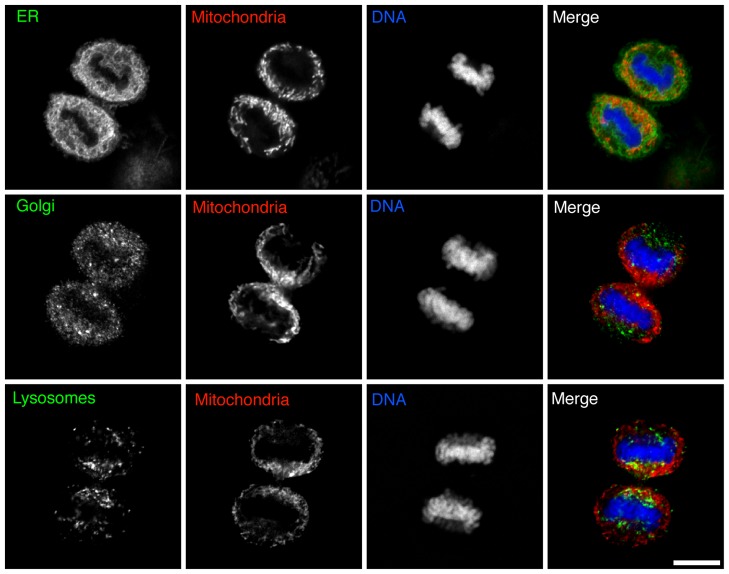
Mitochondrial localization in cytokinesis is distinct from the endoplasmic reticulum, Golgi and lysosomes.Fixed images of HeLa cells in late cytokinesis co-stained for mitochondria (MitoTracker Red, red), DNA (DAPI, blue) and endoplasmic reticulum (anti-GRP-170), Golgi (anti-Golgin-97) or lysosomes (anti-Lamp-1) shown in green. Bar, 10 µm.